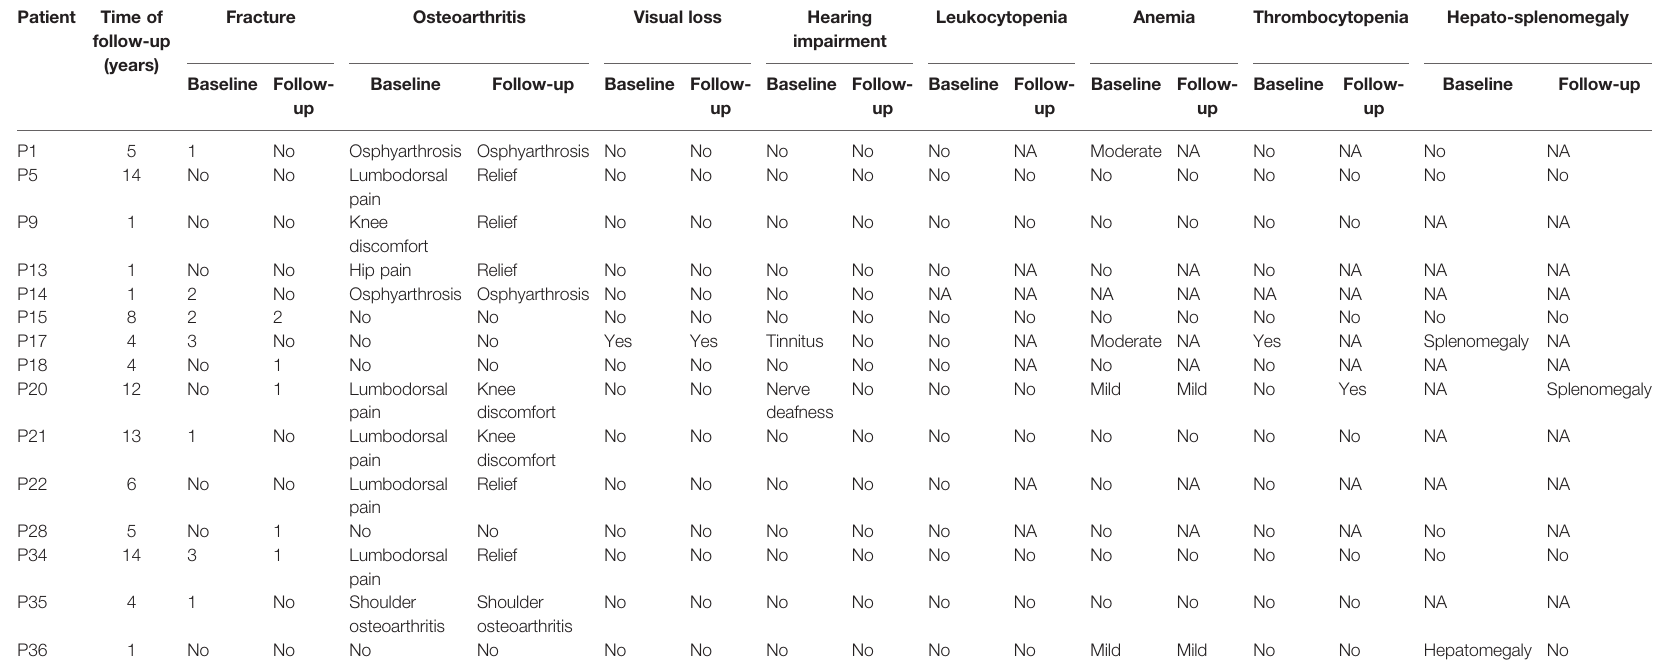
TABLE 5 | Changes in clinical manifestations during follow-up. Patient Time of Fracture Osteoarthritis Visual loss Hearing follow-up (years) Baseline Follow- Baseline Follow-up Baseline Follow- up